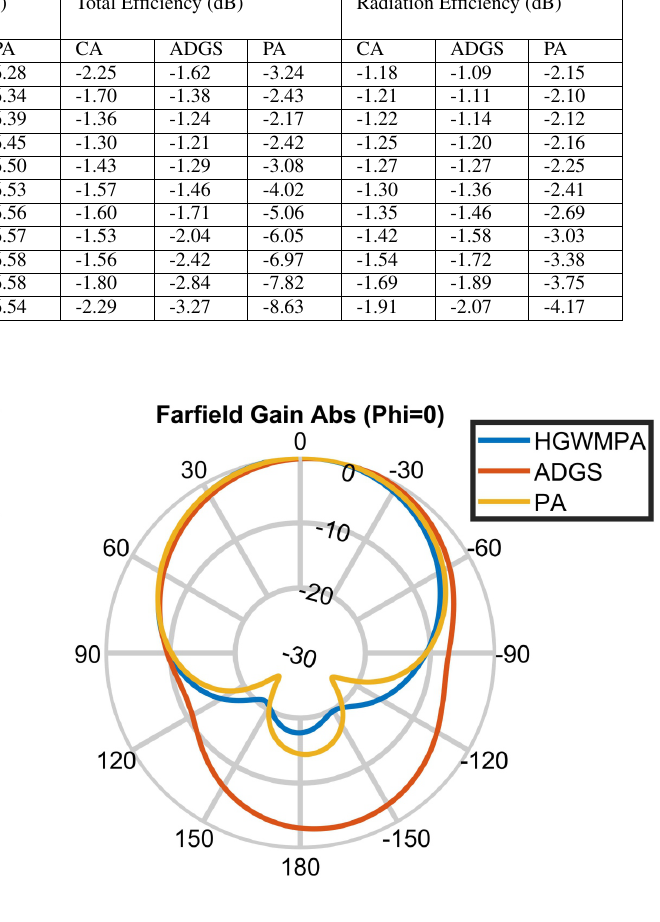
FIGURE 11. Normalized radiation patterns of the PA, ADGS and HGWMPA at 5.8 GHz (Phi=0 deg. plane).